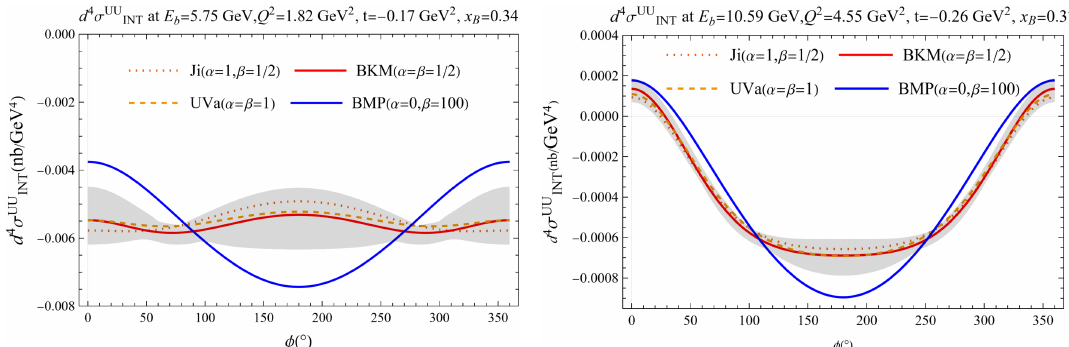
Figure 7 . Comparison of the four-fold interference cross-section d 4 σ UU β . Besides the different lines showing different choice of parameters, the gray band consists of all cross-section results with 0 ≤ α ≤ 1 and 0 ≤ β ≤ 2 . The UVa results shown here are obtained by taking α = β = 1 in our set-up and differ from the actual result in ref. [41] with an overall factor of cos φ